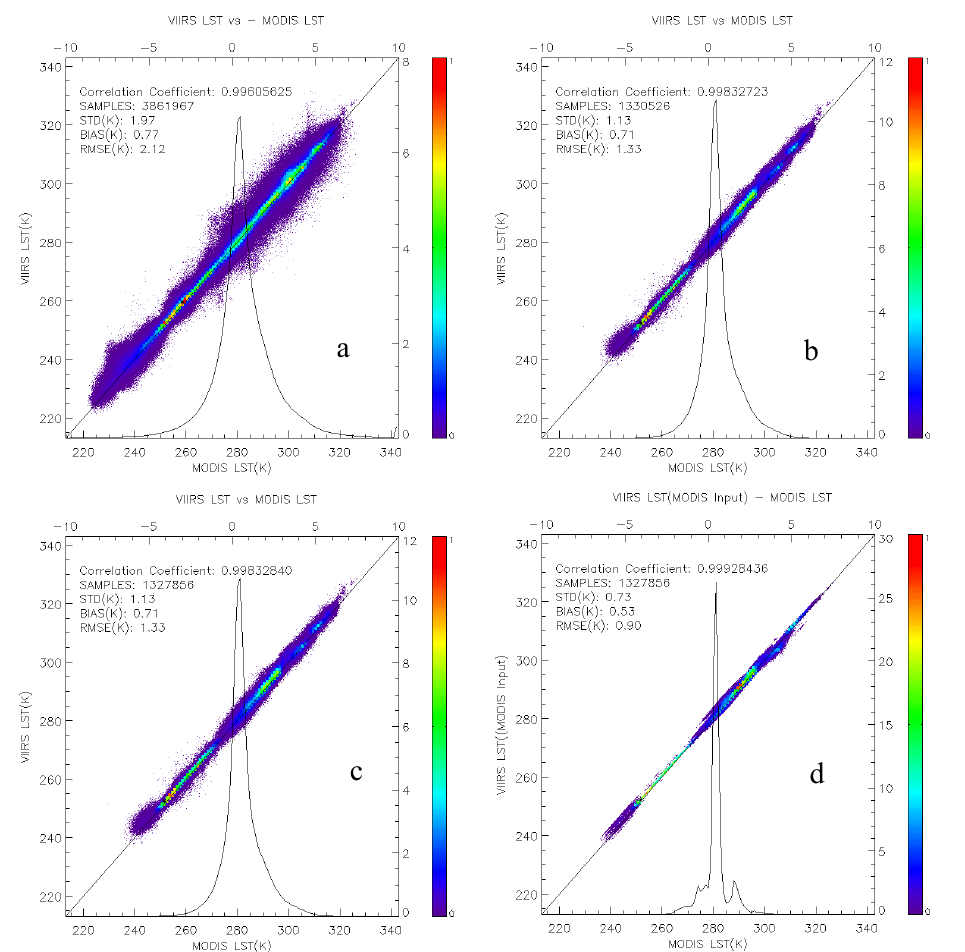
Figure 5. Cross-comparison results between VIIRS and AQUA for the whole period and area under analysis. ( a ) all comparison results under cloud clear condition ; ( b ) based on a, spatial variation tests are added ; ( c ) based on b, angle difference is added ; ( d ) based on c, VIIRS LST is calculated using MODIS data as input and then compare to MODIS